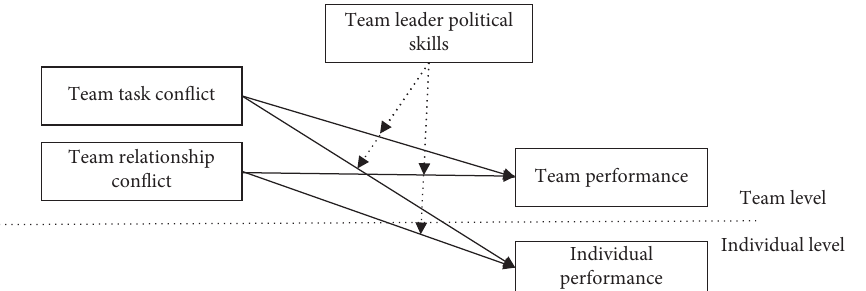
Figure 1: Cross-level model of interactions between team conflict and